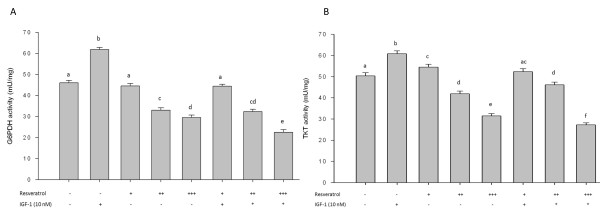
Effect of RSV (50, 100 and 150 μM denoted as +, ++ and +++ respectively) and/or IGF-1 (10 nM) on G6PDH (A) and TKT (B) enzyme activities in HT-29 colon cancer cells. HT-29 cells were treated with RSV and/or IGF-1 for 24 h and G6PDH and TKT enzyme activities were analyzed as described in materials and methods. Results were expressed as means ± SE for three replicate experiments for each treatment group. Means that differ by a common letter (a, b, c, d, e, f) differ (p < 0.05).